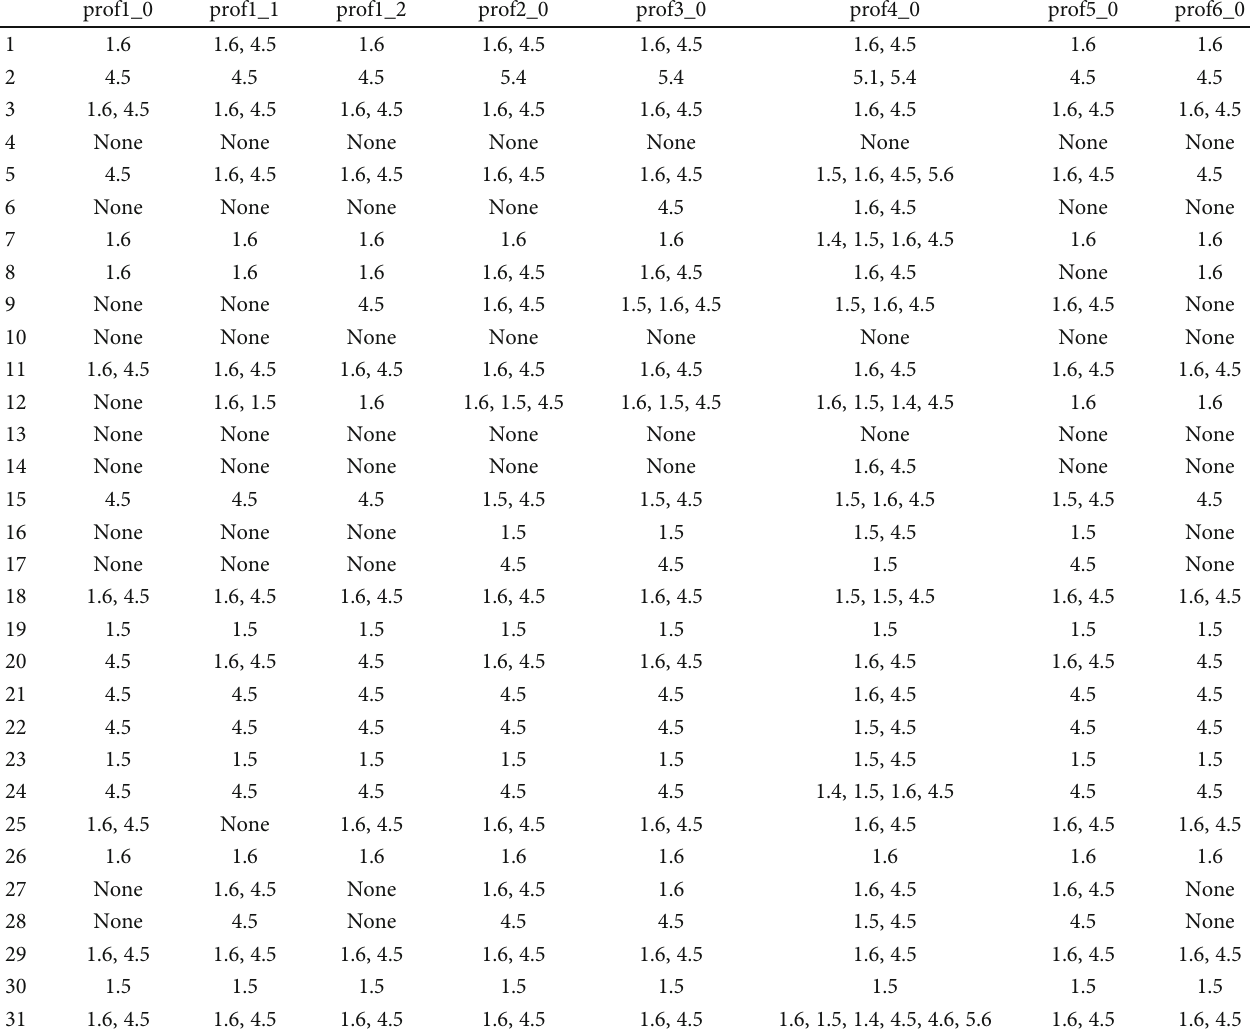
Table 6: The table shows the indices between which there are no signi fi cant di ff erences in a particular game.